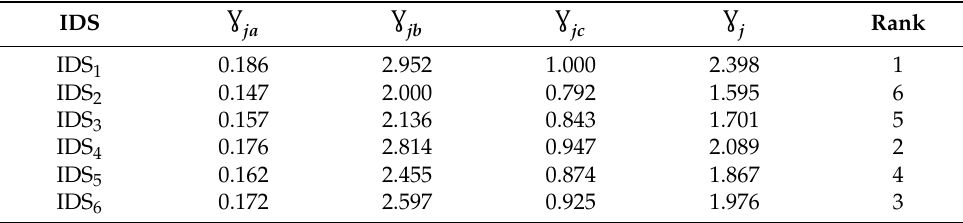
Figure 6. Ranking of the IDSs using the CoCoSo method.